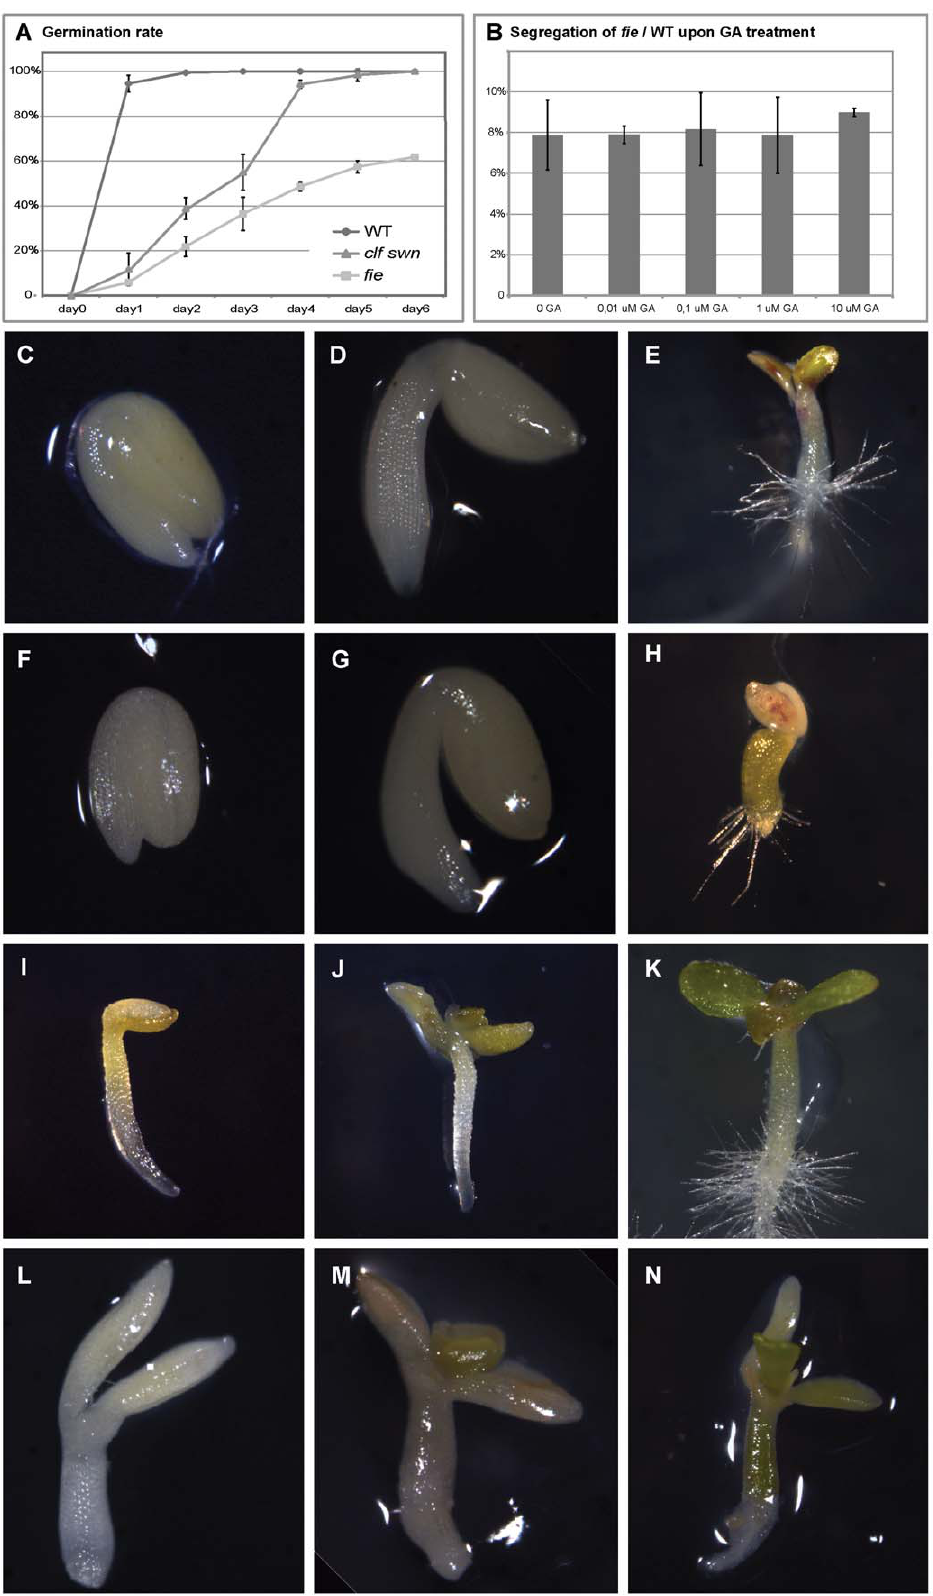
Figure 6. Dormancy and germination phenotypes. (A) Both, homozygous fie and homozygous clf - swn mutants, show a similar delay in germination initially. However, clf swn germinates to 100% whereas 40% of fie seeds stay dormant within at least two weeks on plates. (B) Application of GA does not enhance the germination rate of fie mutant seeds. (C–N) Phenotypical comparison of wild type (C–E, I–K) and fie mutants (F–H, L–N).